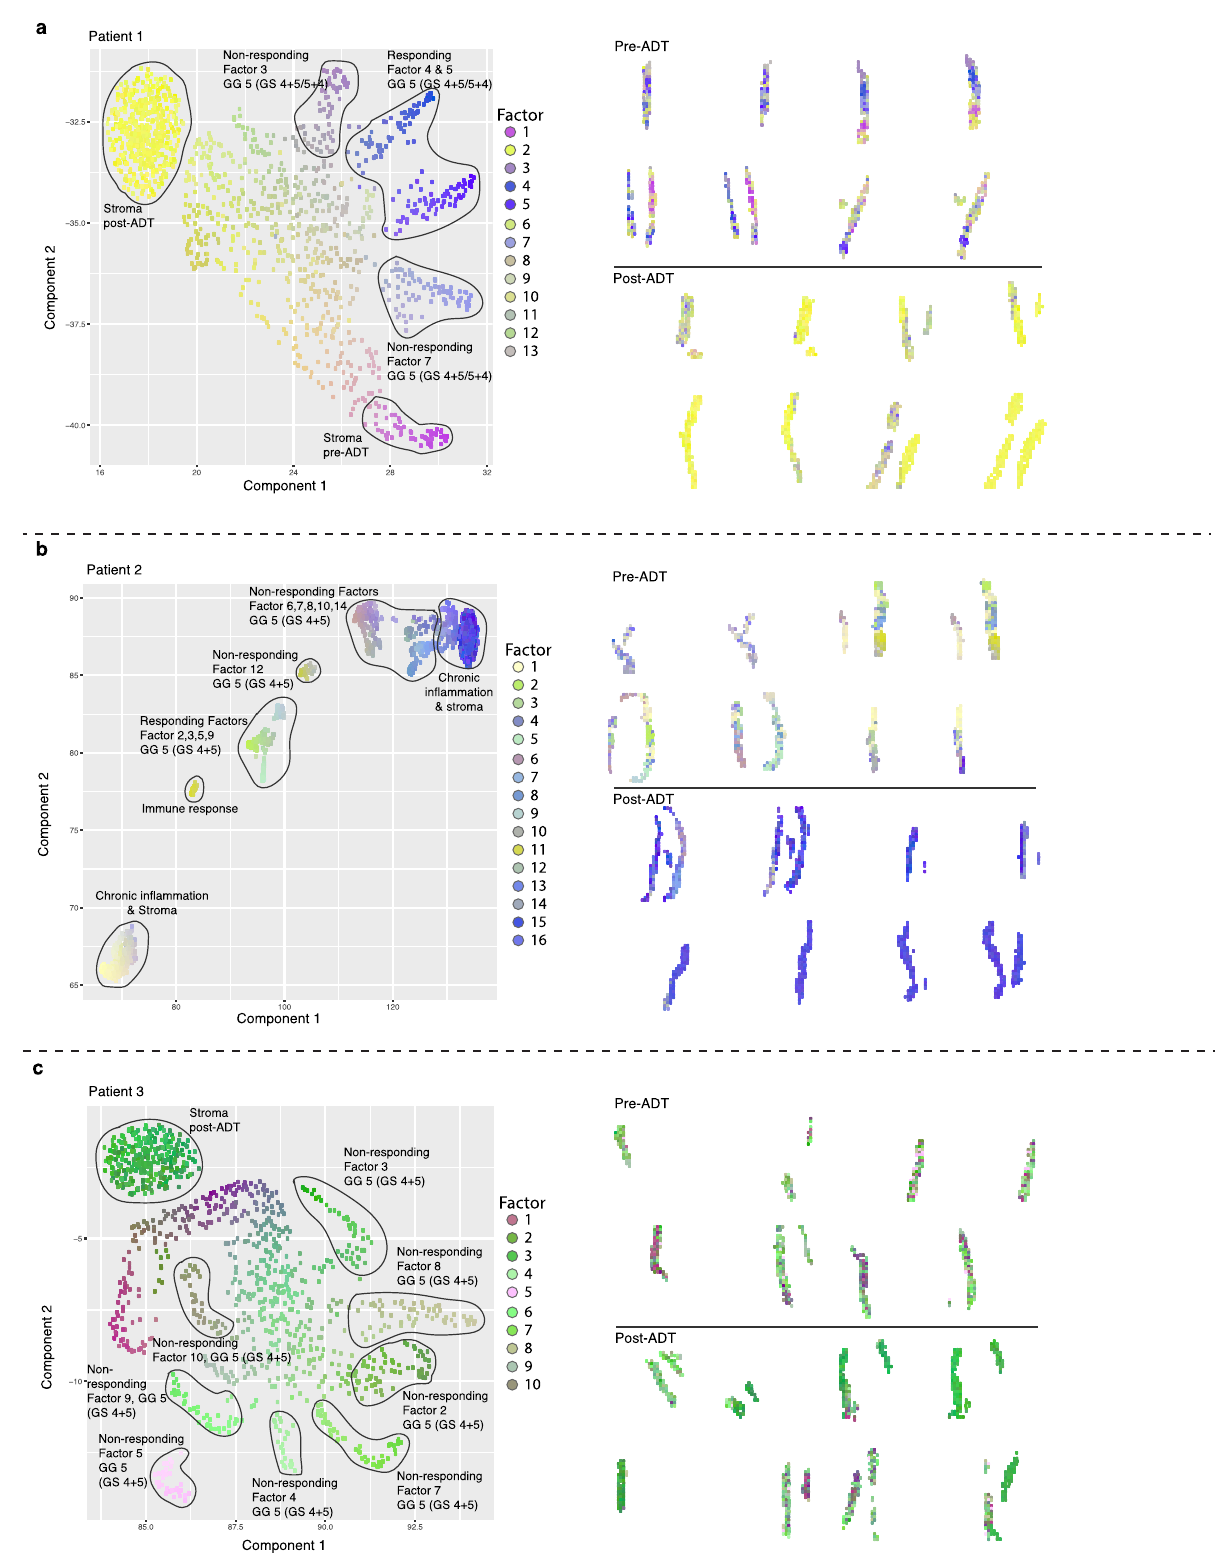
Fig. 3 | UMAP visualization of gene expression factors (left) and the spatial position of gene expression factors (right). a Patient 1- clinical responder. b Patient 2 - moderate responder. c Patient 3 - non-responder. Clusters of spots